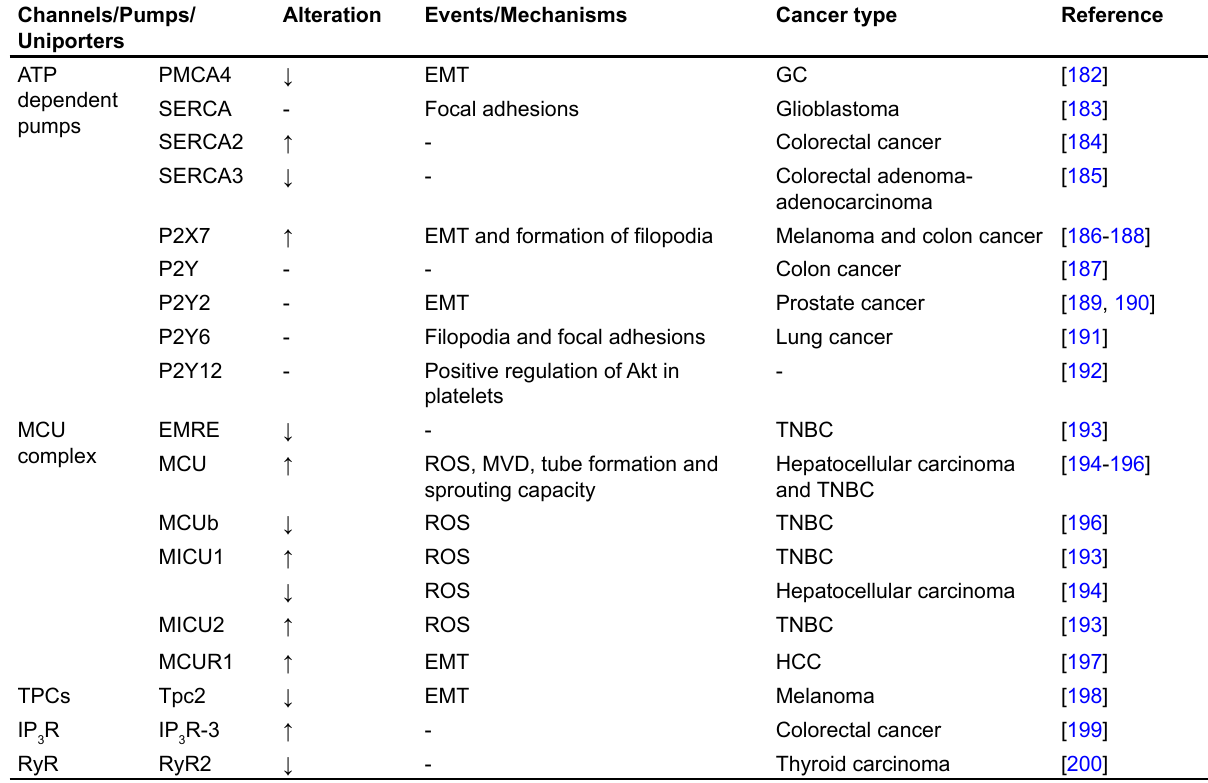
Table 1. Representative studies about Ca 2+ channels/pumps/uniporters in cancer metastasis ( continued )